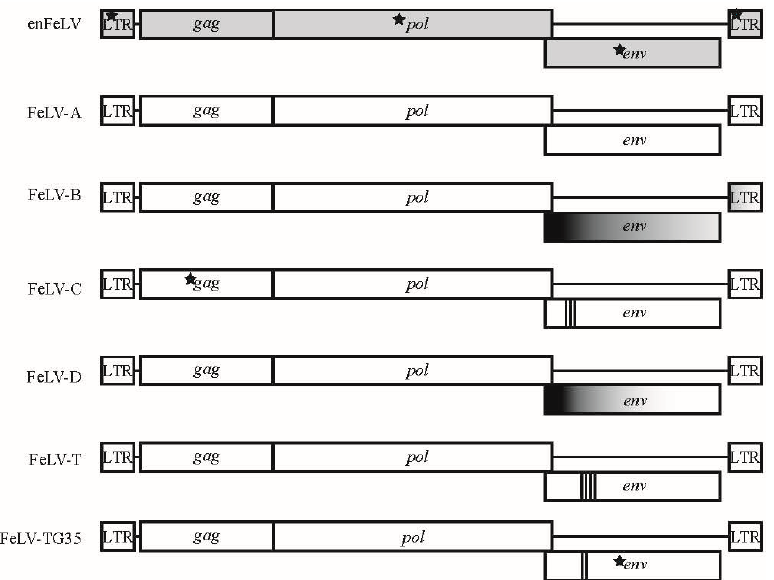
Figure 1. Genomic map of feline leukemia virus (FeLV) subgroups. Six different FeLV subgroups have been associated with different disease outcomes that differ genetically and biologically from endogenous FeLV (enFeLV). EnFeLV is the most genetically distinct from FeLV-A, with nucleotide differences noted in long terminal repeats (LTR), gag , and env . FeLV-B is formed by recombination of the enFeLV env -LTR with FeLV-A. The 5 ′ recombination site is more conserved than the 3 ′ site. FeLV-C, T, and TG35 have focal insertions, substitution, and deletions within the parent FeLV-A virus at different regions. Insertions are most often localized to the 5 ′ env and are demarcated here by bold vertical bars, with each line denoting a minimum of one amino acid insertion. Stars denote presence of single nucleotide polymorphisms (SNPs) that are highly concentrated in the respective genes between FeLV-A and other subgroups. FeLV-D displays a recombination event with another domestic cat endogenous virus (ERV-DC; for simplicity, we have not indicated ERV-DC